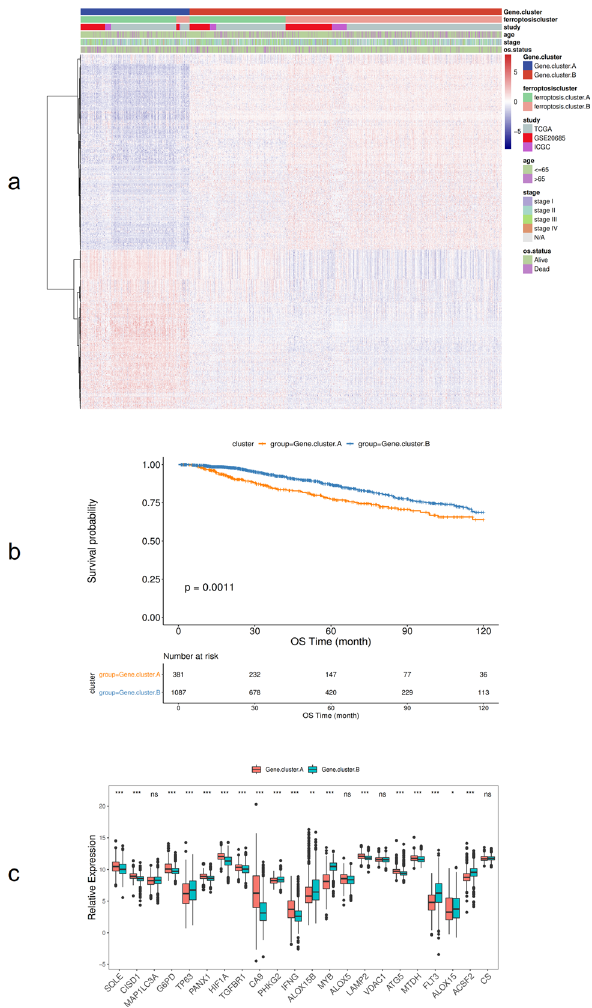
Figure 6. Association of ferroptosis with other datasets and prognosis. ( a ) Unsupervised clustering of genes related to ferroptosis phenotypes in BRCA samples; ( b ) Kaplan–Meier curve showing that ferroptosis gene clusters have a significant relationship with overall survival rate; ( c ) The expression of 22 ferroptosis genes in two gene clusters, * p < 0:05, ** p < 0:01, and *** p <